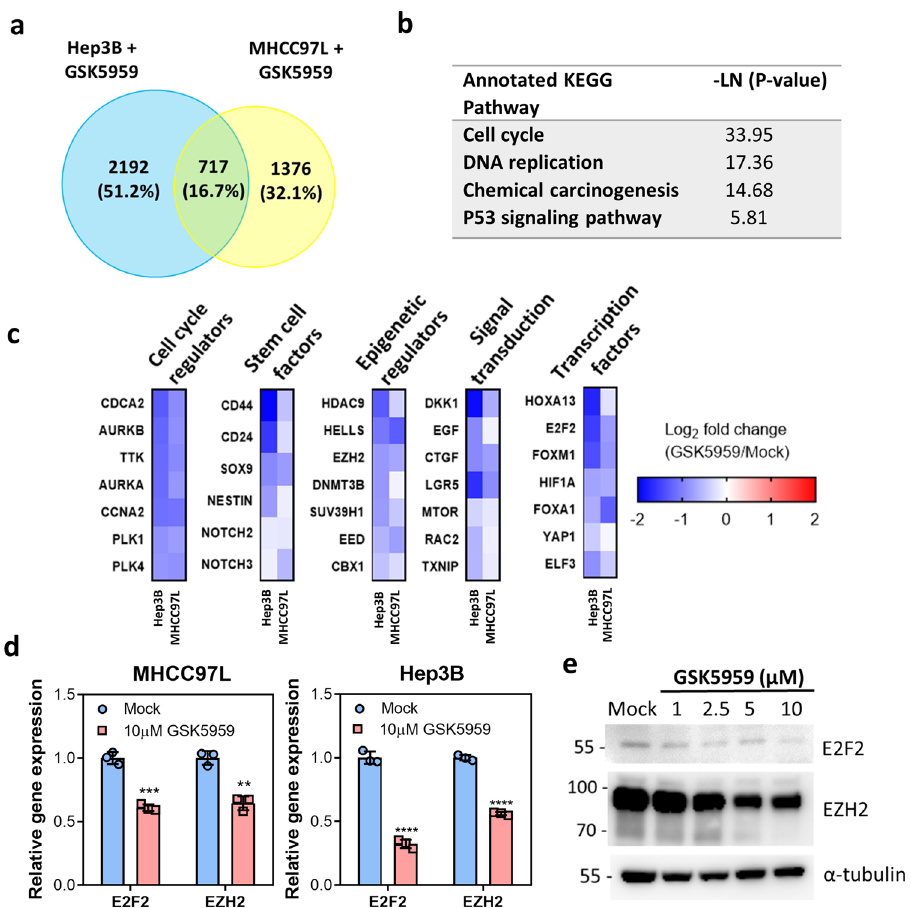
Fig. 7 RNA-seq data identi fi ed E2F2 and EZH2 as the downstream targets of BRPF1. a RNA-seq identi fi ed differentially expressed genes in MHCC97L and Hep3B cells treated with 10 μ M GSK5959 for 24 h. b KEGG pathway analysis of the common downregulated genes from the RNA-seq results. c GSK5959 treatment selectively led to reduced expression of key oncogenes essential for cancer growth and progression. d The mRNA expression levels of E2F2 and EZH2 were downregulated by GSK5959 treatment after 24 h in MHCC97L and Hep3B. e GSK5959 inhibited the protein levels of E2F2 and EZH2 in a dose-dependent manner after 5-day treatment. Error bars indicate mean ± SD. Data were compared by independent t -test. Results were repeated at least three times. ** P < 0.01, *** P < 0.001, **** P < 0.0001 vs mock as